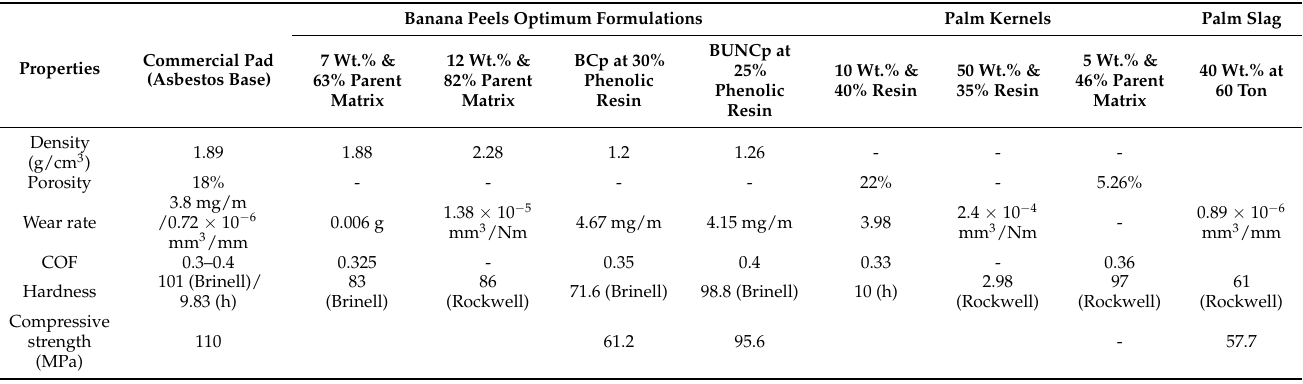
Table 4. The optimum formulation in each article relative to the researcher point of view and the commercial